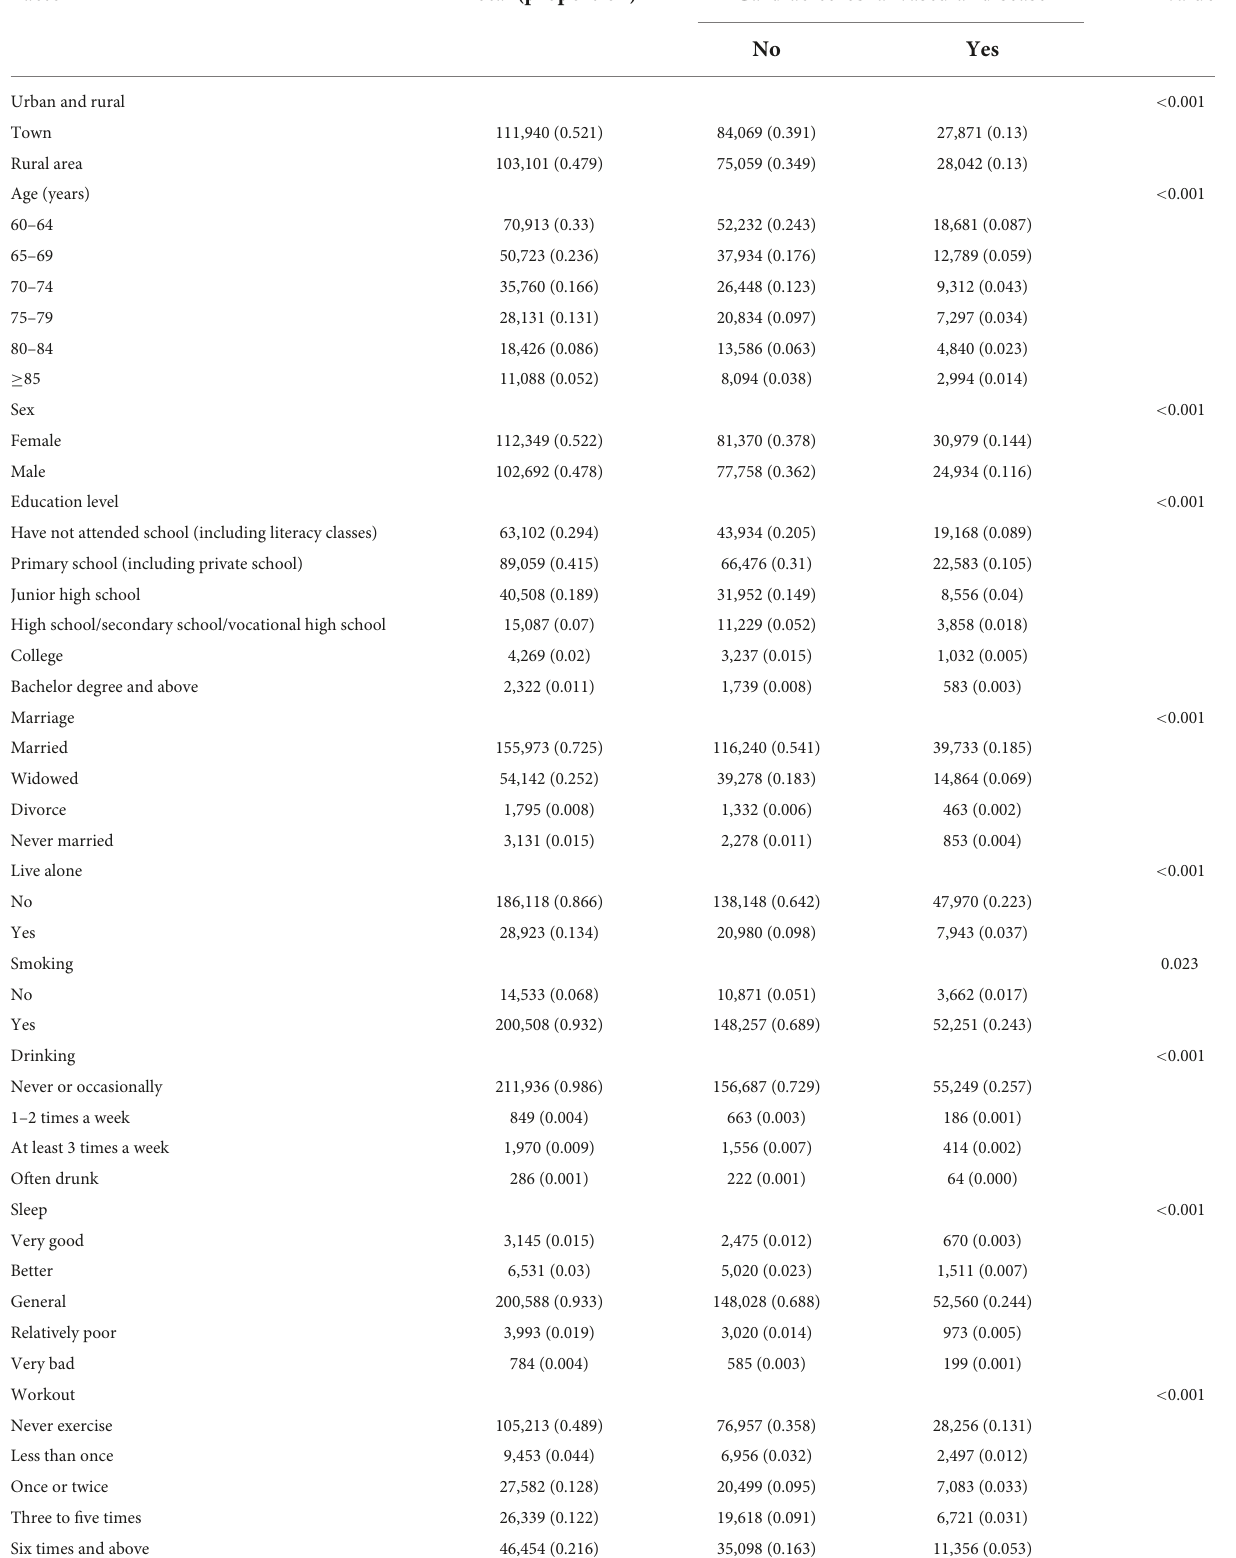
TABLE 1 The based characteristics of participants with (or without) cardiac-cerebral vascular disease. Factor Total (proportion) Cardiac-cerebral vascular